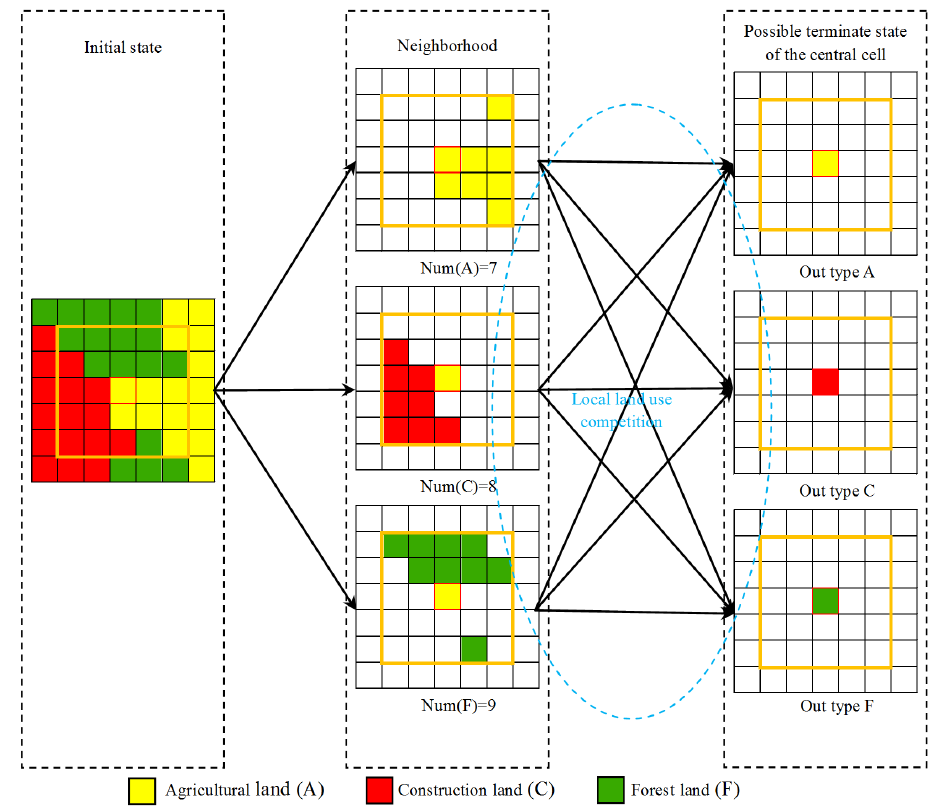
Figure 2. Sketch of mutual competition between different land use type cells in the neighborhood.